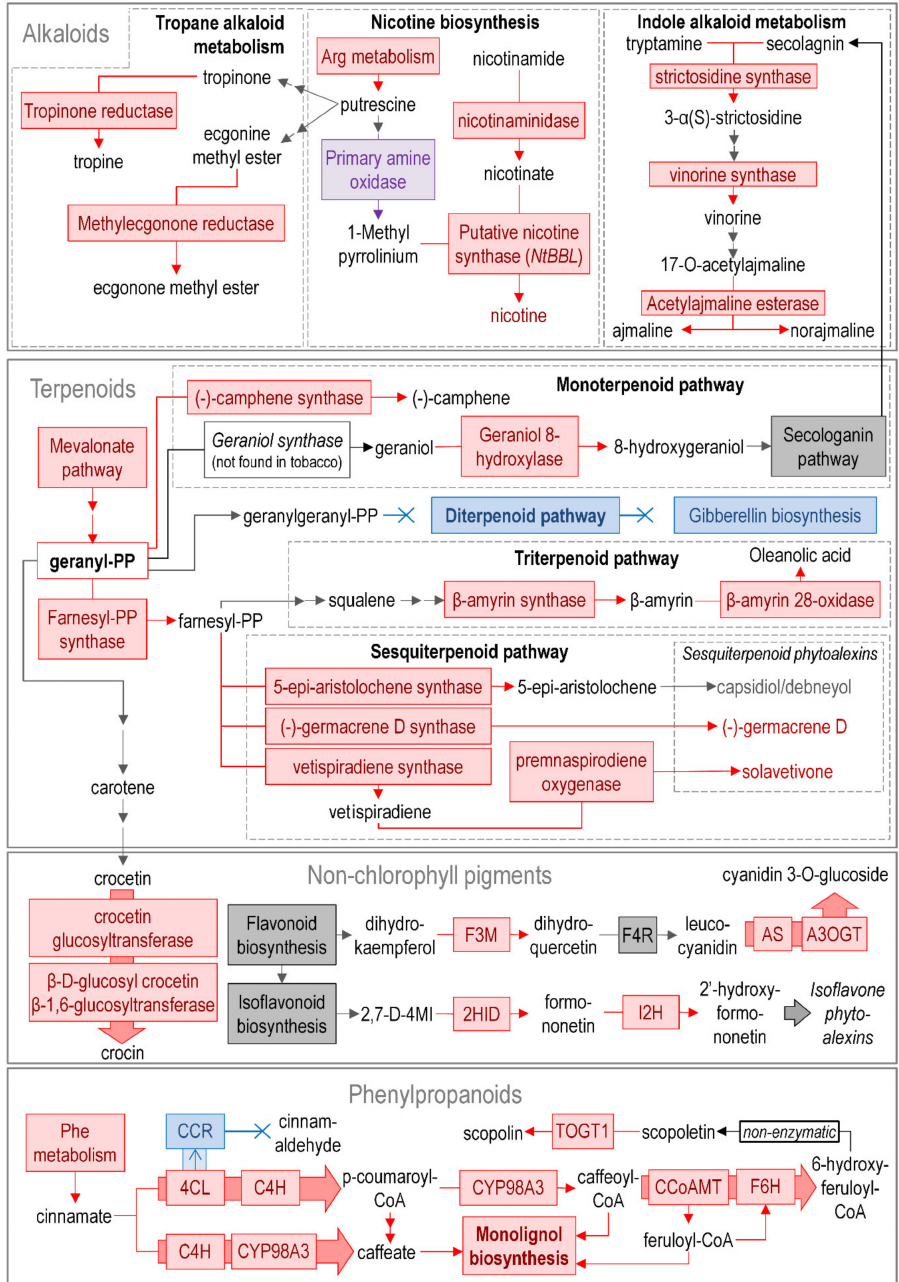
Figure 6. Regulation of genes related to the secondary metabolism in tobacco plants infected by P. atrosepticum . The reactions catalyzed by the enzymes encoded by mostly upregulated, mostly downregulated, non-DEGs, and both up- and downregulated DEGs are marked in red, blue, gray, and purple, respectively. F3M, flavonoid 3 (cid:48) -monooxygenase; F4R, flavanone 4-reductase; AS, anthocyanidin synthase; A3OGT, anthocyanidin 3-O-glucosyltransferase; 2,7-D-4MI, 2,7-dihydroxy-4 (cid:48) -methoxyisoflavanone; 2HID, 2-hydroxyisoflavanone dehydratase; I2H, isoflavone 2 (cid:48) -hydroxylase; 4CL, 4-coumarate-CoA ligase; C4H, cinnamate-4-hydroxylase; CCR, cinnamoyl-CoA reductase; CCoAMT, ca ff eoyl-CoA O-methyltransferase; F6H, feruloyl-CoA 6-hydroxylase; TOGT1, scopoletin glucosyltransferase. The scheme was assembled based mostly on KEGG reference pathways as well as the SwissProt database and sources of literature cited in the